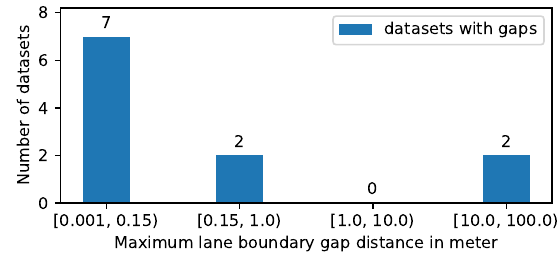
Figure 18. Distribution of maximum gap distances between linked lane